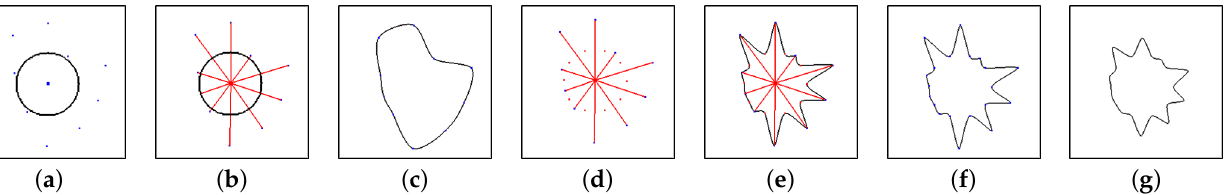
Figure 7. Glyph generation of a 10-D cluster. ( a ) Boundary points representing each dimension. ( b ) Visualization of variances of dimensions (red lines from the center). ( c ) Boundary generated by points in ( a ). ( d ) Insertion of intermediate points with length of local minimum standard deviation (SD) from the center between every pair of the initial boundary points. ( e , f ) Boundary generated by points in ( d )—it visualizes the heterogeneous shape much better. ( g ) Boundary generated by smaller maximum